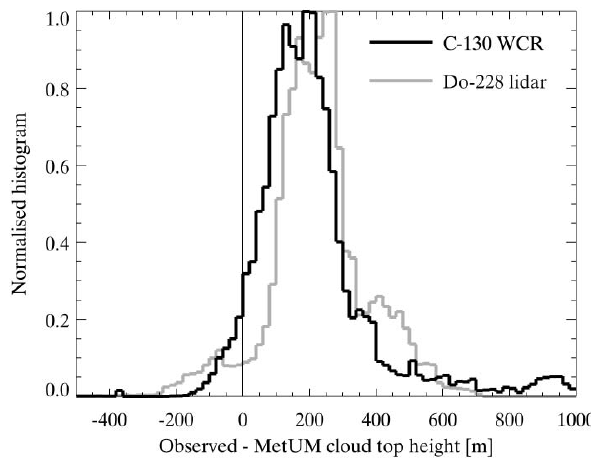
Fig. 4. Histogram of the difference between aircraft observations and the MetUM forecast of cloud top height along the 20 ◦ S latitude